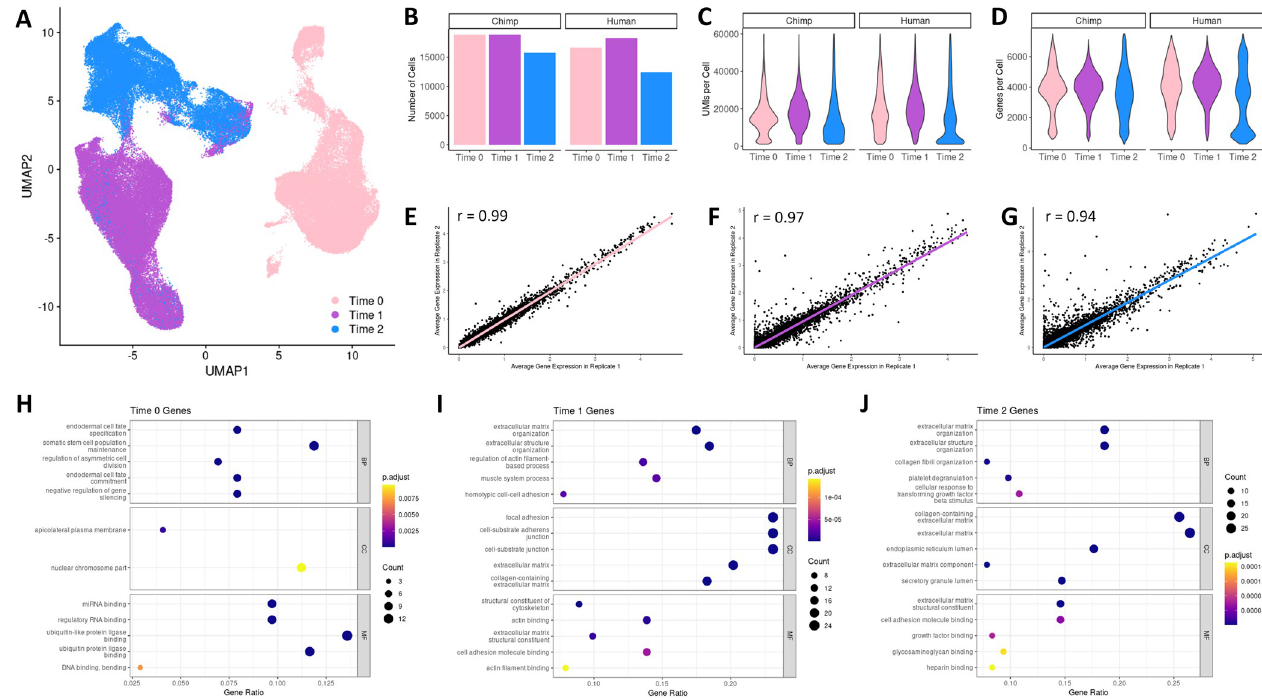
Fig 2. scRNA-seq data recovery is similar across species and reproducible across replicates. UMAP dimensional reduction plot of scRNA-seq data with cells labeled by the stage of differentiation at which they were collected (A), along with a bar plot depicting the number of chimpanzee and human cells collected at each stage of differentiation (B), violin plots displaying the distribution of UMI counts per cell (C) and gene counts per cell (D), and the correlation of average gene expression patterns between technical replicates (human and chimpanzee) collected in pluripotent cells (Time 0) (E), mesenchymal cells (Time 1) (F), and osteogenic cells (Time 2) (G). Enrichment of GO functional categories among marker genes for cells collected at each stage of differentiation (H-J). The top 5 GO functions identified in biological processes (BP), cell components (CC), and molecular functions (MF) are displayed along with the adjusted p-value (p- adjust), the number of marker genes overlapping a GO function (Count), and the ratio of overlapping to non-overlapping marker genes for a given GO function (GeneRatio).